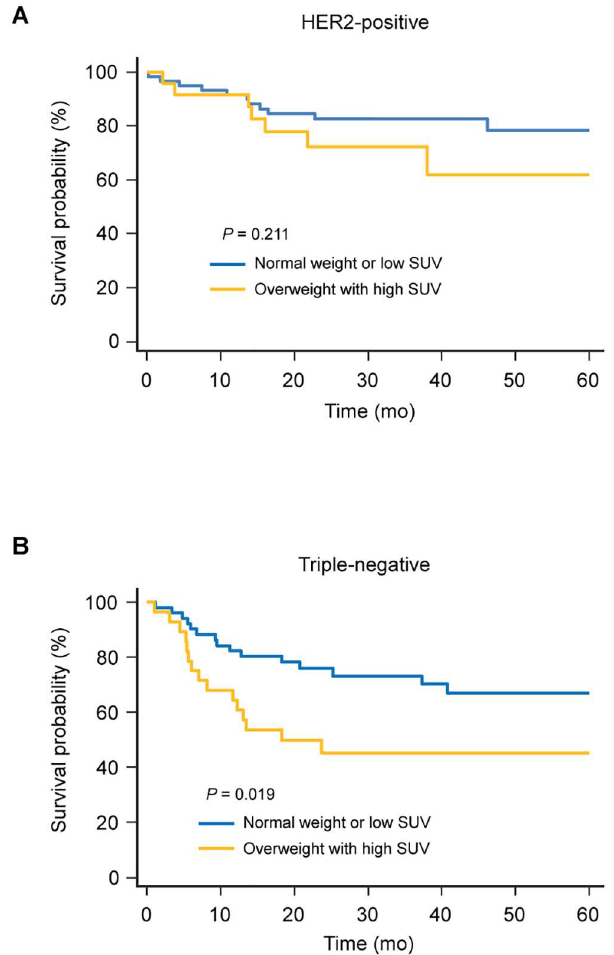
Fig 2. Kaplan-Meier survival curves for recurrence-free survival according to BMI with tumor SUV in patients with HER2-positive (A) and triple-negative disease (B). BMI, body mass index; SUV, standardized uptake